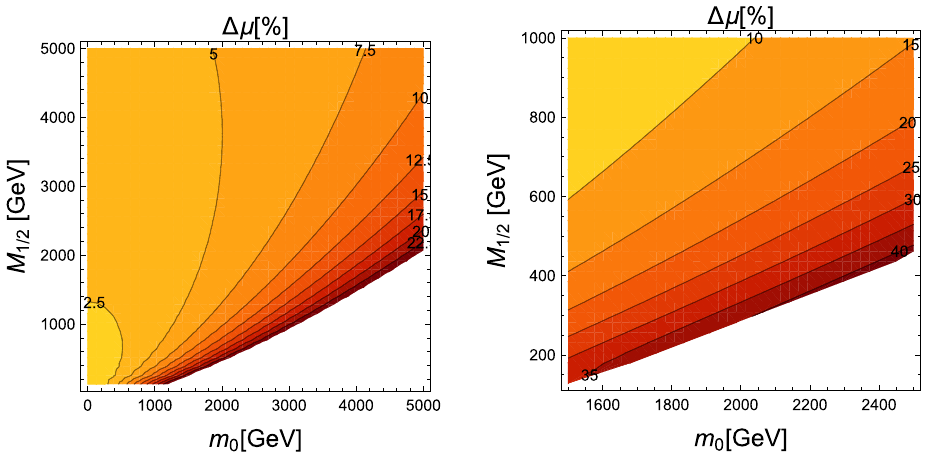
Fig. 7 The same as Fig. 5 for the value of μ at the SUSY scale. The right plot is a zoom into the interesting region of the left one